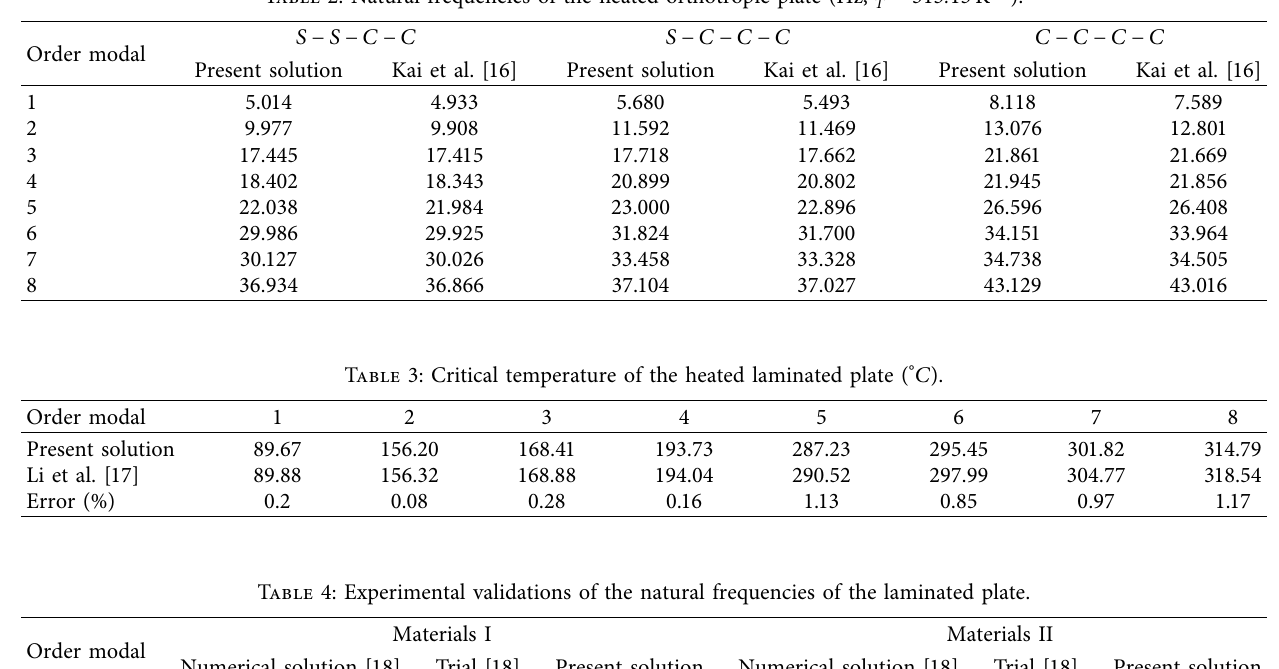
Table 2: Natural frequencies of the heated orthotropic plate (Hz;